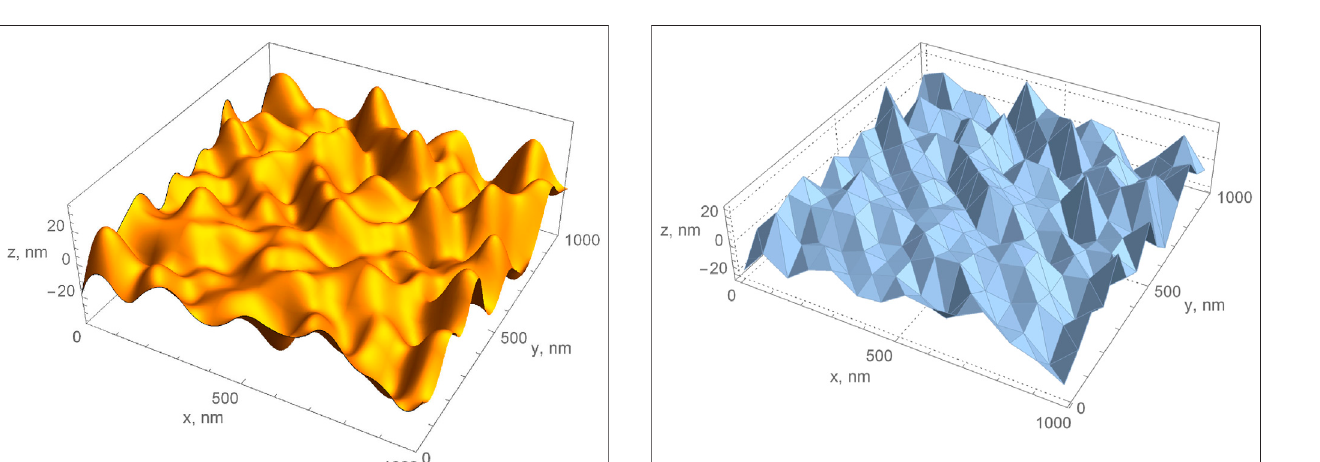
FIGURE 2 | Representation of the surface of Figure 1 by the set of discrete areas.